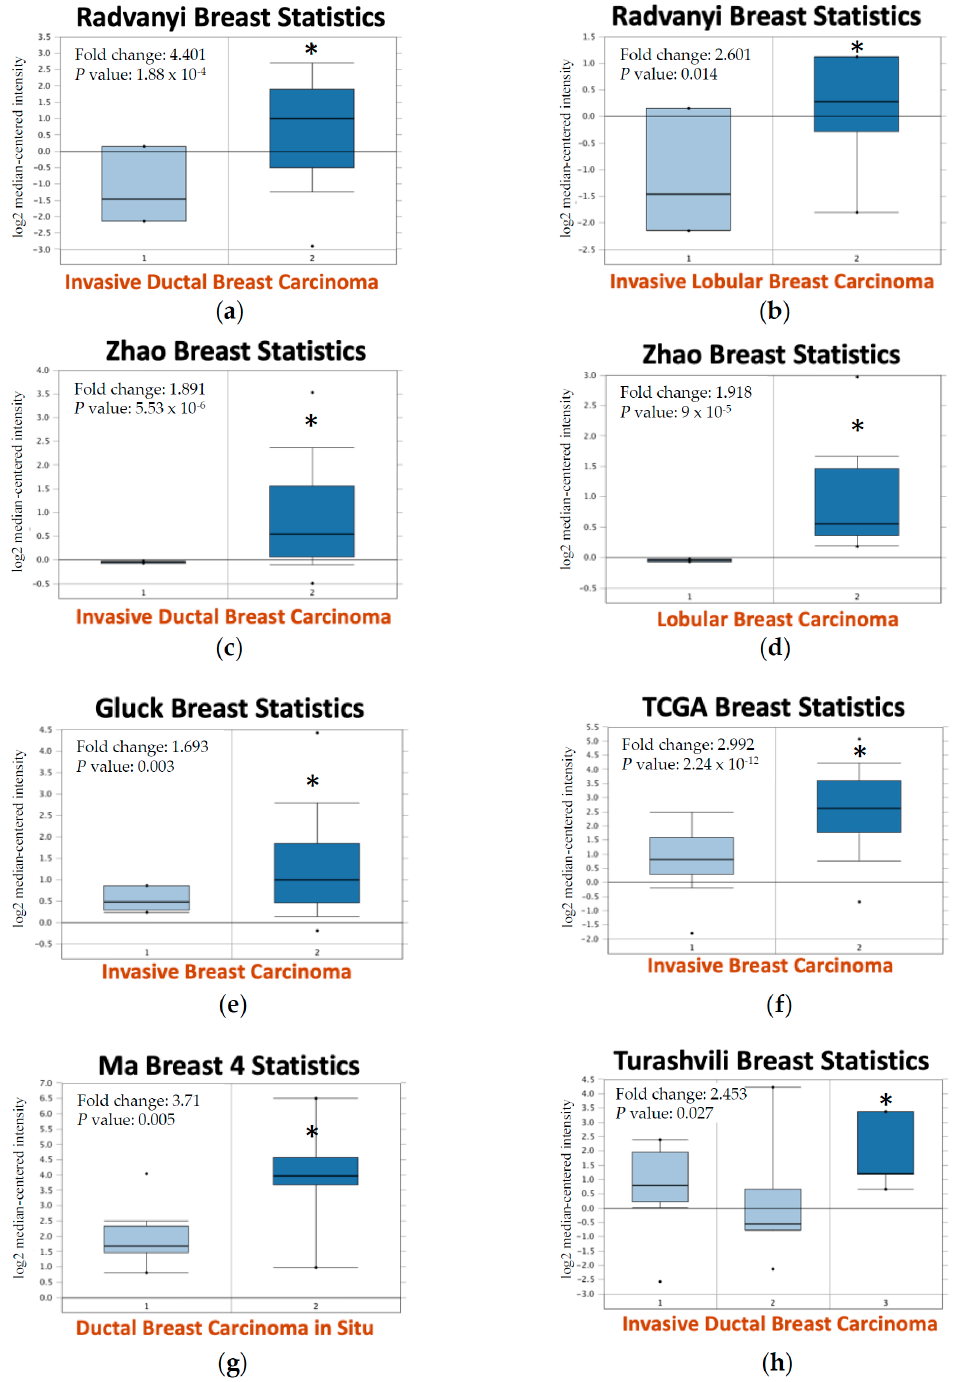
Figure 2. The analysis of KMO mRNA expression comparison between normal tissues and cancer tissues using the Oncomine database. ( a , b ) Analyzed from the ‘Radvanyi Breast Statistics’ cohort; ( c , d ) analyzed from the ‘Zhao Breast Statistics’ cohort; ( e ) analyzed from the ‘Gluck Breast Statistics’ cohort; ( f ) analyzed from the ‘TCGA Breast Statistics’ cohort; ( g ) Analyzed from the ‘Ma Breast 4 Statistics’ cohort; ( h ) analyzed from the ‘Turashvili Breast Statistics’ cohort. Statistical analysis was compared with related non-cancerous tissues. (1, non-cancerous tissues ( a – g ); 2, breast cancer tissues ( a – g ); 1, ductal breast tissues ( h ); 2, lobular breast tissues ( h ); 3, breast cancer tissues ( g ); *, p < 0.05).